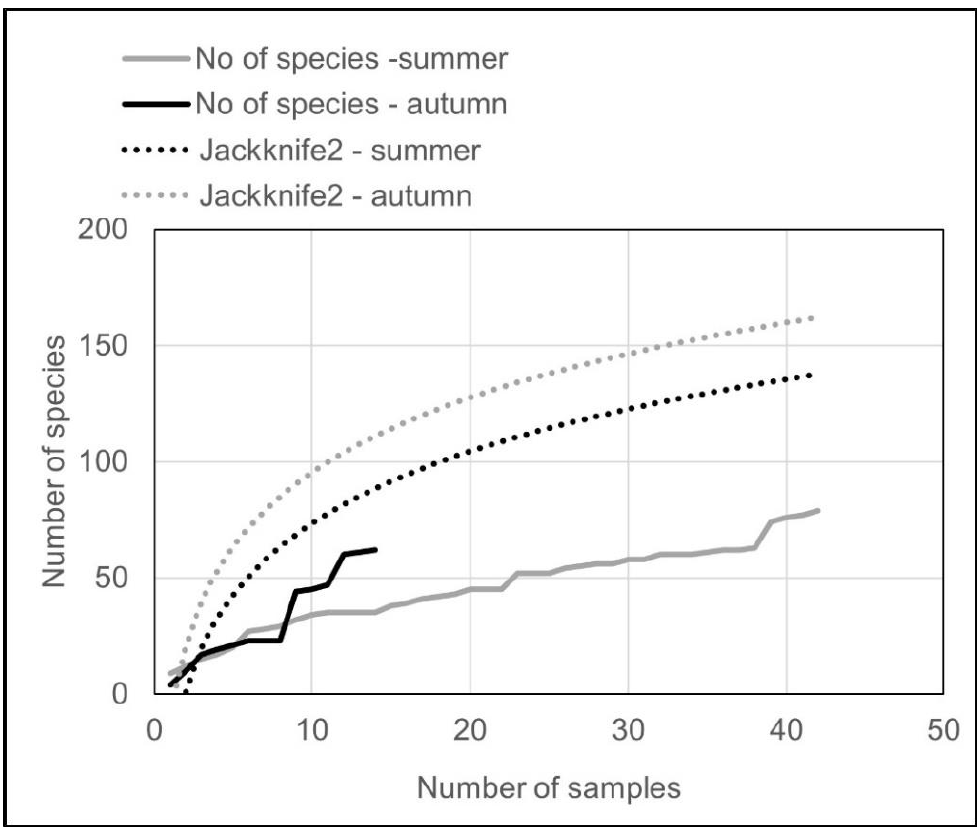
Figure 3. Accumulated (solid line) and estimated by Jackknife2 (dotted line) rotifer species richness in summer and autumn sets of streams. Table 3. A list of rotifer species. their maximum abundance and frequency in the springs of the Knyszyn Forest; single observations are marked with stars (*); supplymentary materials